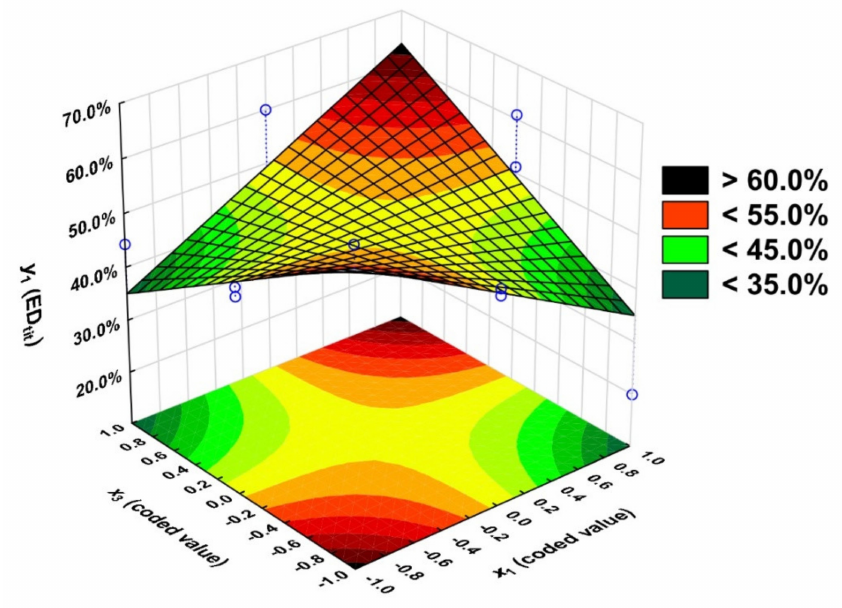
Figure 10. Dependence of esterification degree (ED tit ) of PGItc, on the OH/COOH ratio ( x 1 ) and the time ( x 3 ), x 2 =